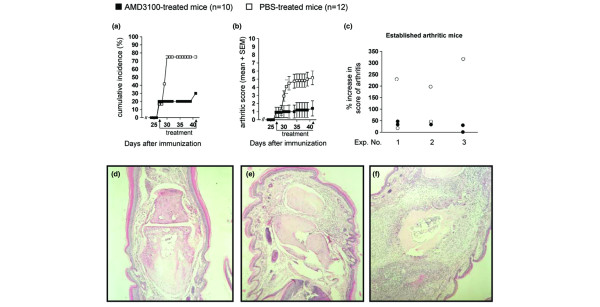
Inhibition of collagen-induced arthritis in DBA/1 mice by treatment with AMD3100. Mice were immunized on day 0 with collagen type II in complete Freund's adjuvant and were observed for symptoms of arthritis. On day 27, when the first symptoms of arthritis appeared, the mice were divided into two groups in a way that a similar incidence and a similar average clinical score was reached in both groups. On this day, mice of one group were implanted with osmotic minipumps, delivering AMD3100 for two weeks at a constant rate of 600 μg/day. Mice of the other group were implanted with pumps containing PBS. The (a) cumulative incidence and (b) mean arthritic score ± standard error of the mean (SEM) for AMD3100-treated and control-treated mice are shown. Average group scores of arthritis were significantly different from day 30 onwards (p ≤ 0.05 on day 30; p ≤ 0.01 from day 31 till the end of the experiment, Mann-Whitney U test). (c) Evaluation of disease progression in mice with established arthritis at initiation of treatment with AMD3100. Circles represent percentage increase in scores of arthritis for individual mice at the end of the treatment. Data show the results of three individual experiments (explained in more detail in the legend of Table 1). (d-f) Histological analysis of the joints. On the last day of treatment, five mice out of both groups with a mean score representing the average group score, were selected and sacrificed. Paraffin sections of the fore and hind limbs were haematoxylin stained and histological examination was performed. Representative pictures are shown. (d) Joint of an AMD3100-treated mouse without clinical symptoms showing normal histological appearance. (e) Joints of arthritic AMD3100-treated mice show a weak infiltration of mono- and polymorphonuclear cells and hyperplasia of the synovium. (f) Joint section of a PBS-treated mouse, showing moderate to severe infiltration of leukocytes, hyperplasia and bone destruction.